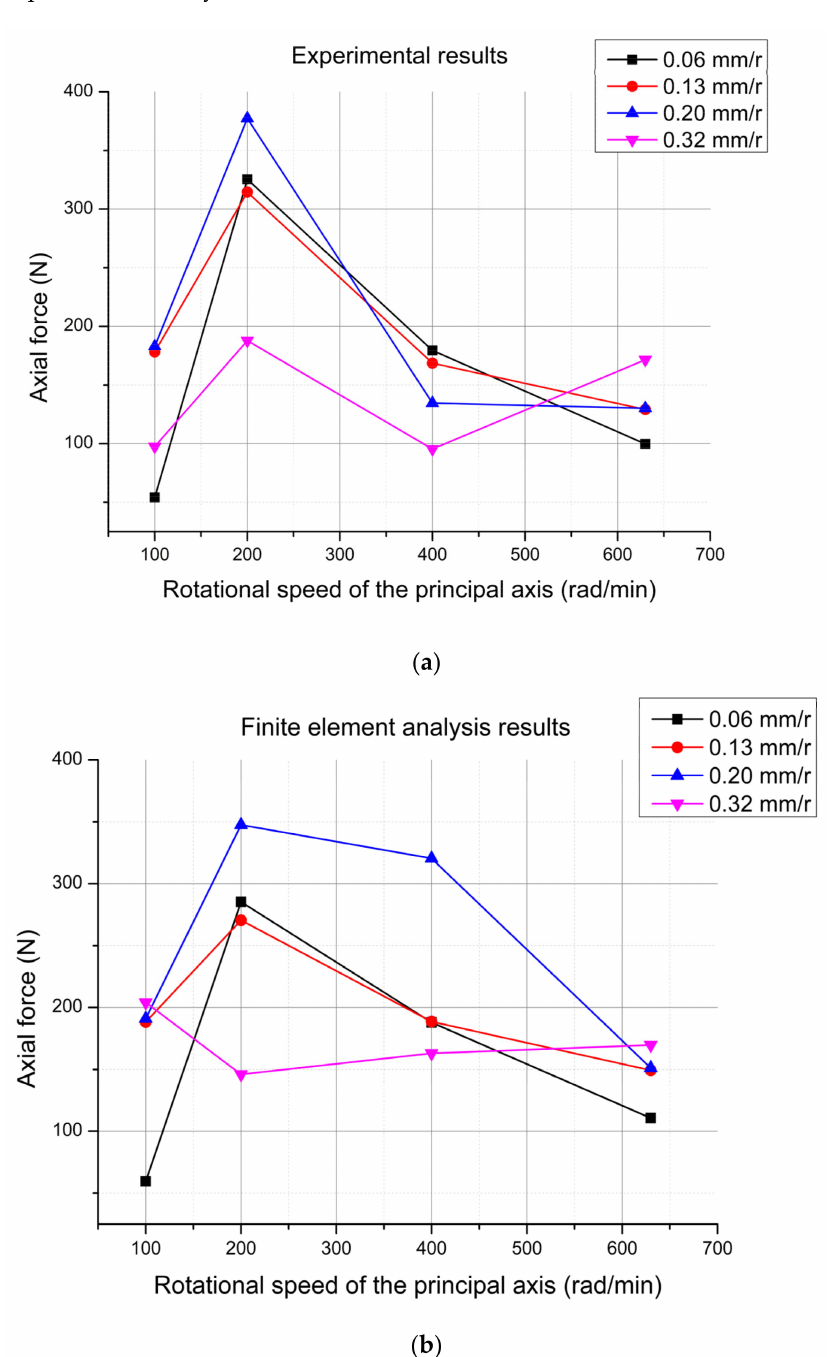
Figure 9. Experimental data 1 for granite. ( a ) During the test, the axial force changes with the rotational speed under different feed rates. ( b ) Finite element analysis results corresponding to the